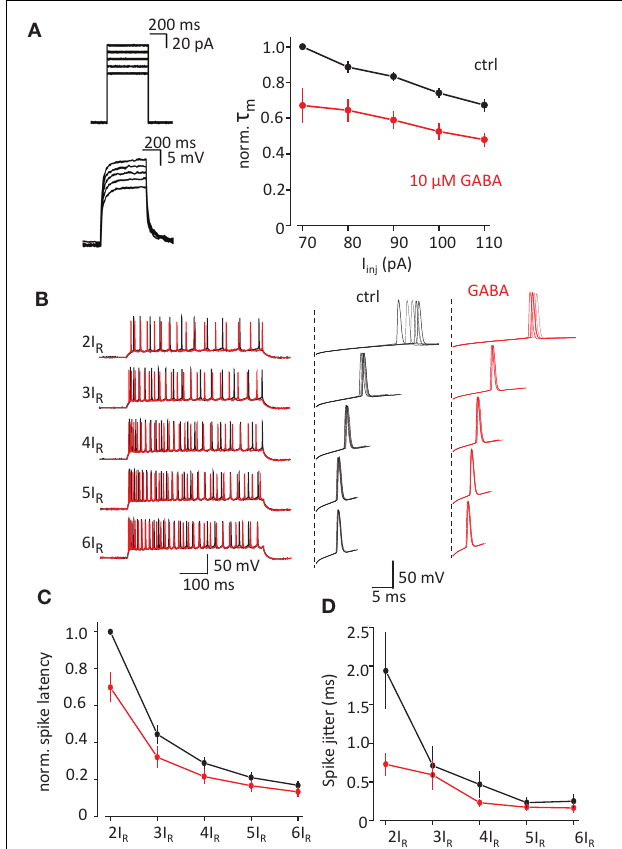
FIGURE 1 | Change in τ m by exogenous GABA correlates with decrease in spike latency and spike jitter. (A) τ m measured from the timecourse of voltage change in response current injection. APs were blocked with intracellular QX-314Br. Left , sample traces of current injection ( above ) and corresponding voltage changes ( below ). Right , normalized τ m in response to different current injections in control conditions ( black trace ) and in the presence of GABA ( red trace ). (B) APs recorded in response to current injection adjusted to 2–6 rheobases (2I R –6I R ). Left , full traces. Right , zoomed first APs in the responses showing spike latency and spike jitter. Black traces—control, red traces—in the presence of GABA. (C , D) Summary data for the change in the spike latency and spike jitter by exogenous GABA. Data presented as mean ± s.e.m. (error bars). Statistical comparison is discussed in the